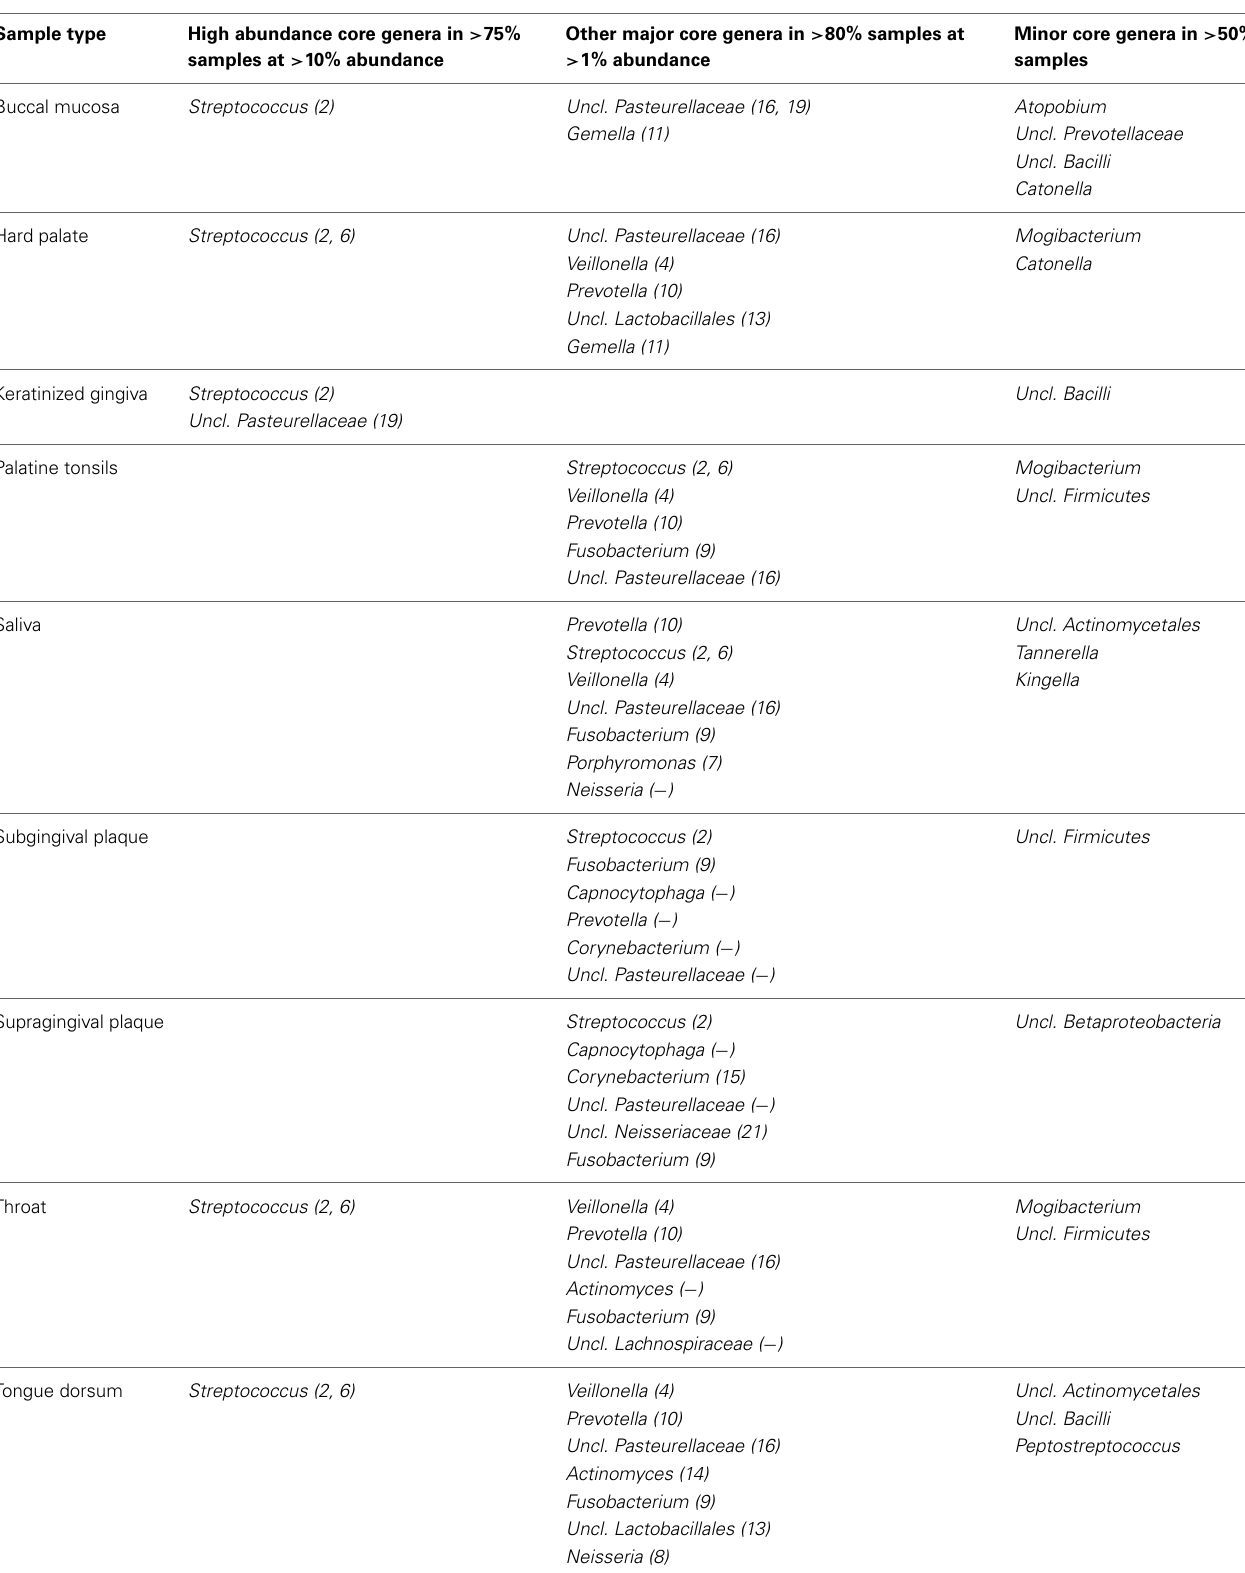
Table 1 | The core bacterial taxa in the oral cavity from over 200 healthy individuals participating in HMP (Li et al., 2013). Sample